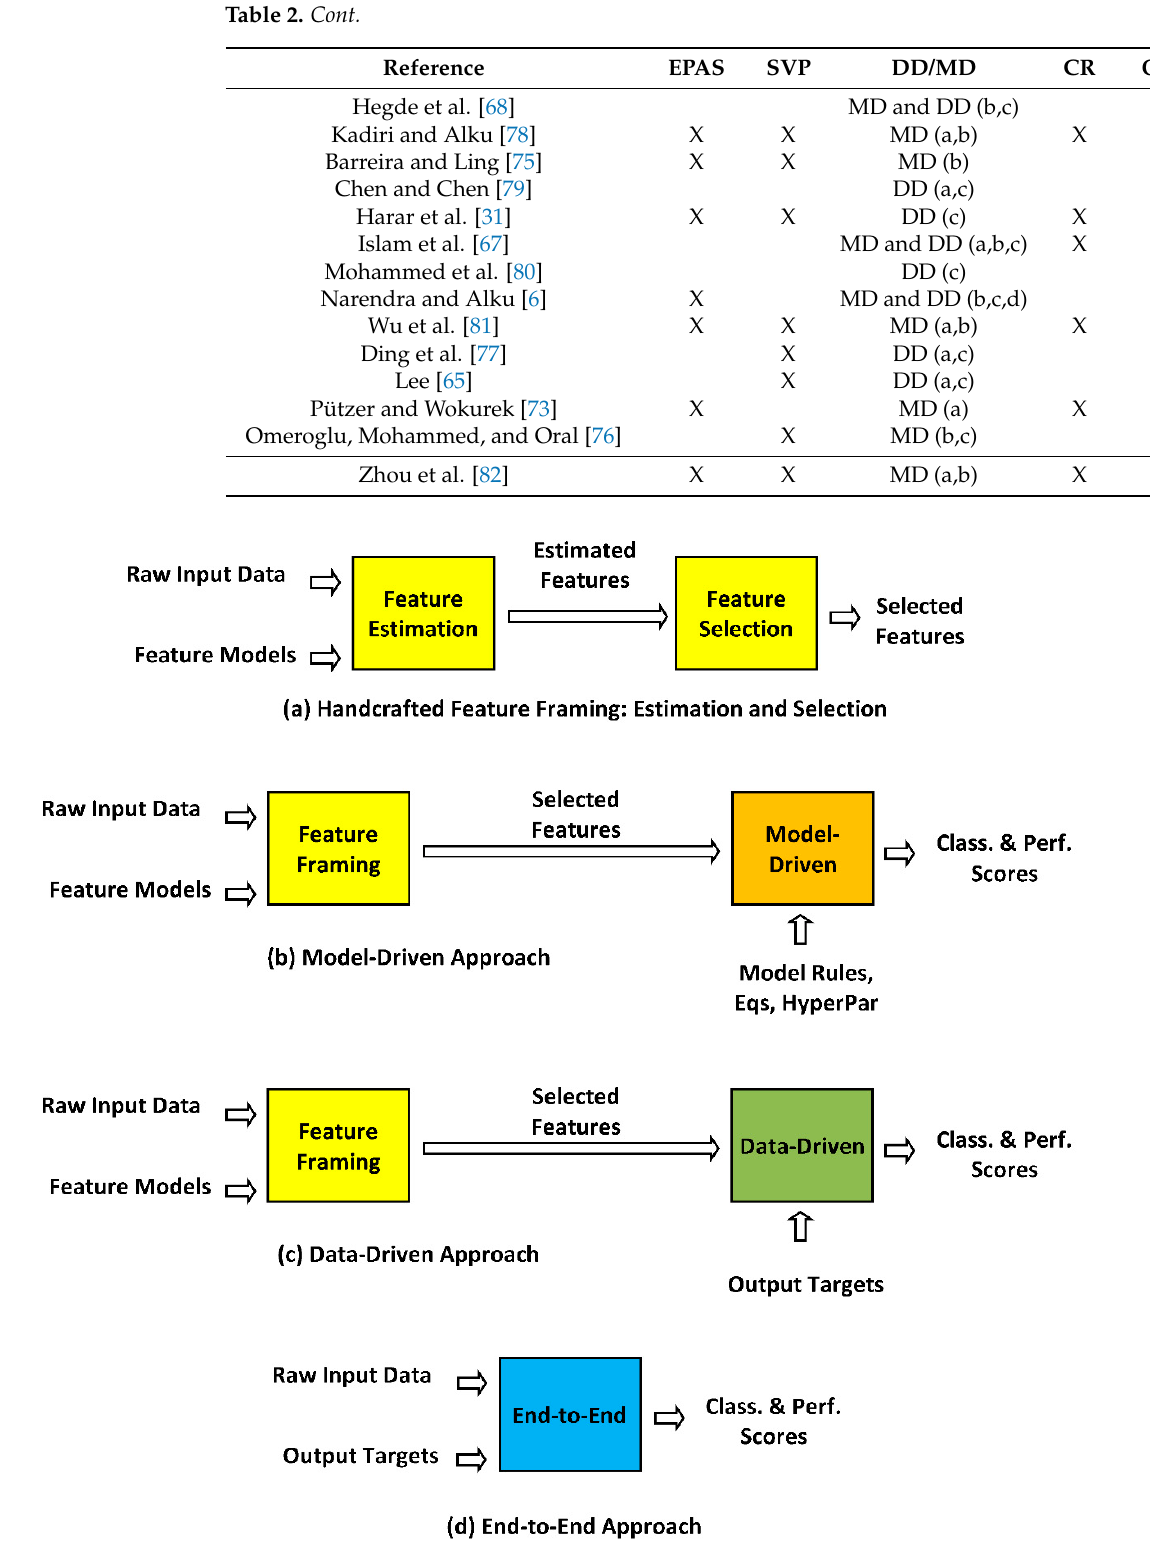
Figure 3. Different strategies for ML pathology detection and classification: ( a ) Handcrafted feature framing, comprising feature estimation followed by feature selection, based on physiological and acoustical models of voice production to estimate input features; ( b ) Model-driven approach, using features extracted by ( a ) and detection and classification model rules and mathematical structures such as Gaussian mixture models, random forests, shallow neural networks, support vector ma- chines, etc. to estimate classification and performance scores; ( c ) Data-driven approach, also using features modeled by ( a ) and detection and classification by deep learning methods as deep neural networks, associating expected output targets on intensive numerical computation to estimate clas- sification and performance scores; ( d ) End-to-end approach, where stage ( a ) is omitted, using direct raw input data and desired output targets to produce classification and performance scores. Classi- cally, MD ( b ) and DD ( c ) approaches take input features provided by a previous HF stage ( a ). End- to-end approaches do not require a previous HF stage ( a ). • Many studies tend to use a small set of publicly available databases, which include a few sustained vowels only. In other words, they might not be sufficiently representa- tive of the pathologies targeted and of the population affected, overtraining on a lim- ited dataset, hampering generalization. In this sense, the following publicly available